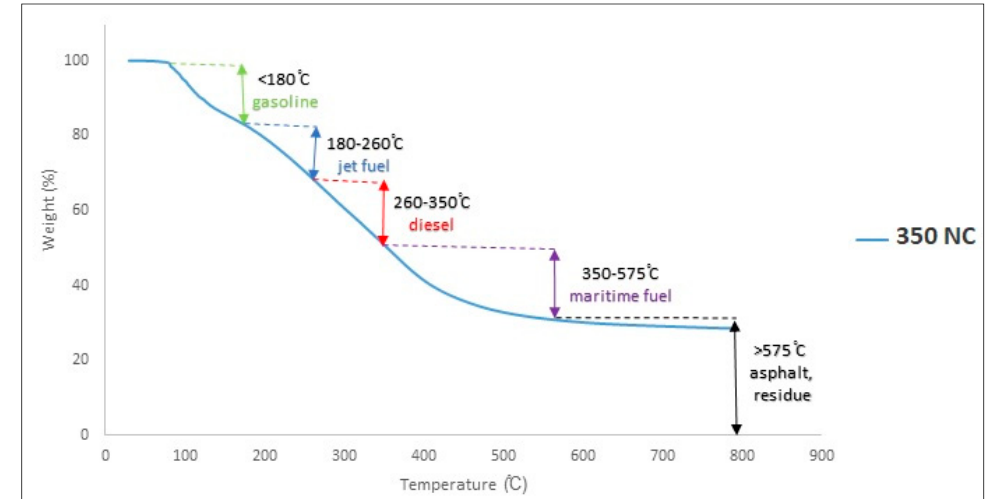
Figure 2. Thermogravimetric curves of the biocrudes obtained at 350 °C.